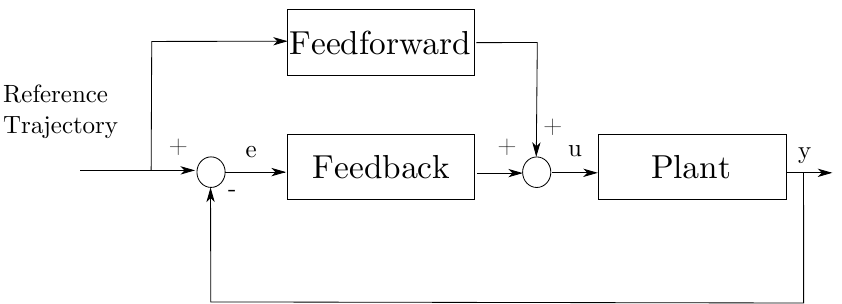
Figure 5. Two Degree of Freedom